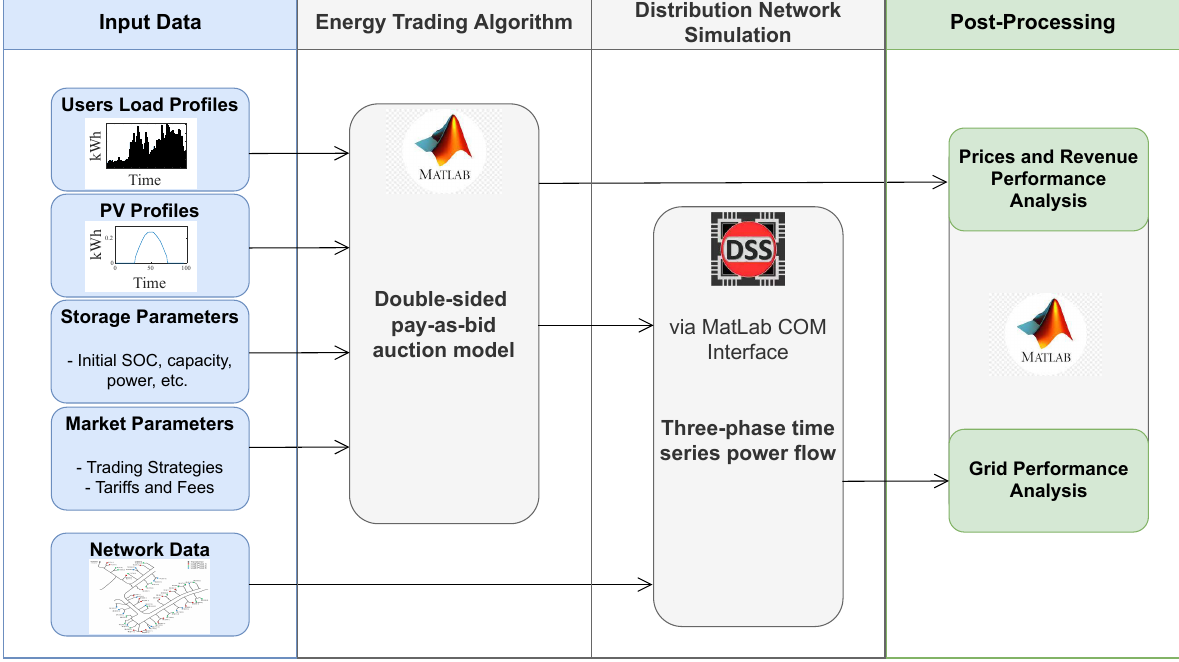
Figure 2. Simulation model